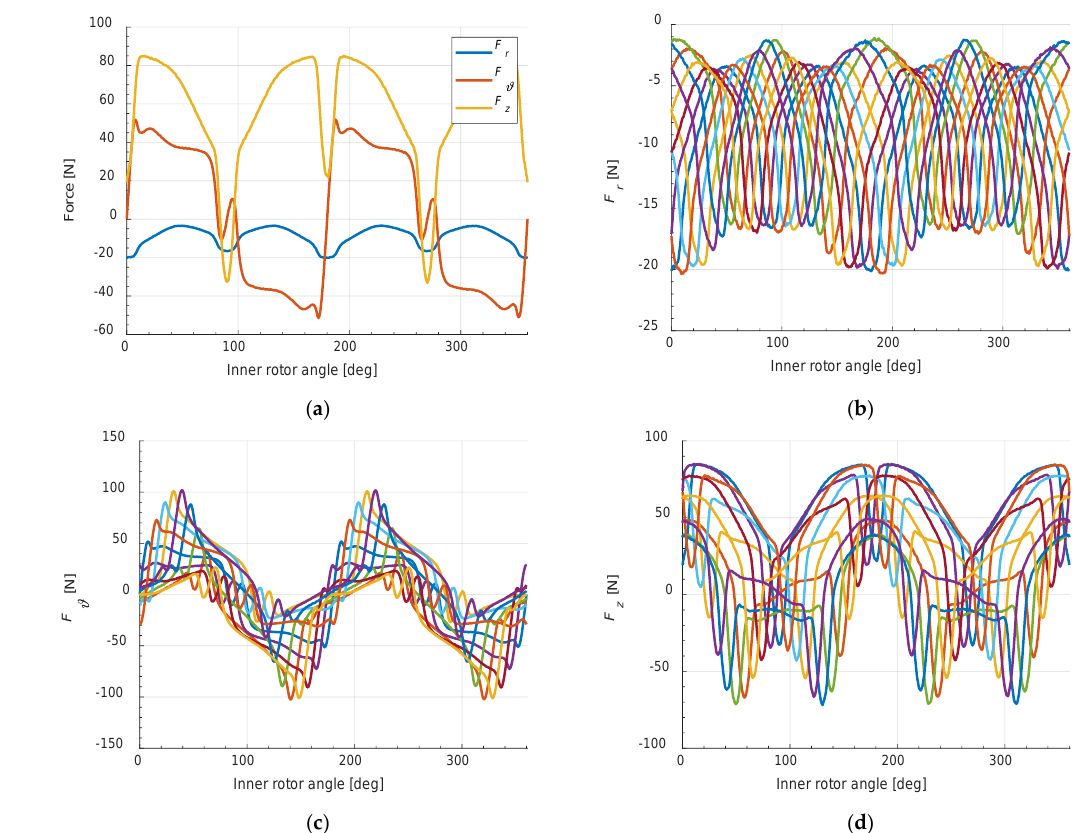
Figure 5. Local forces components ( F r , F ϑ , F z ,) of MG 2 ( a ) in reference to single pole piece no. P 1 , ( b – d ) for all cores P 1 –P